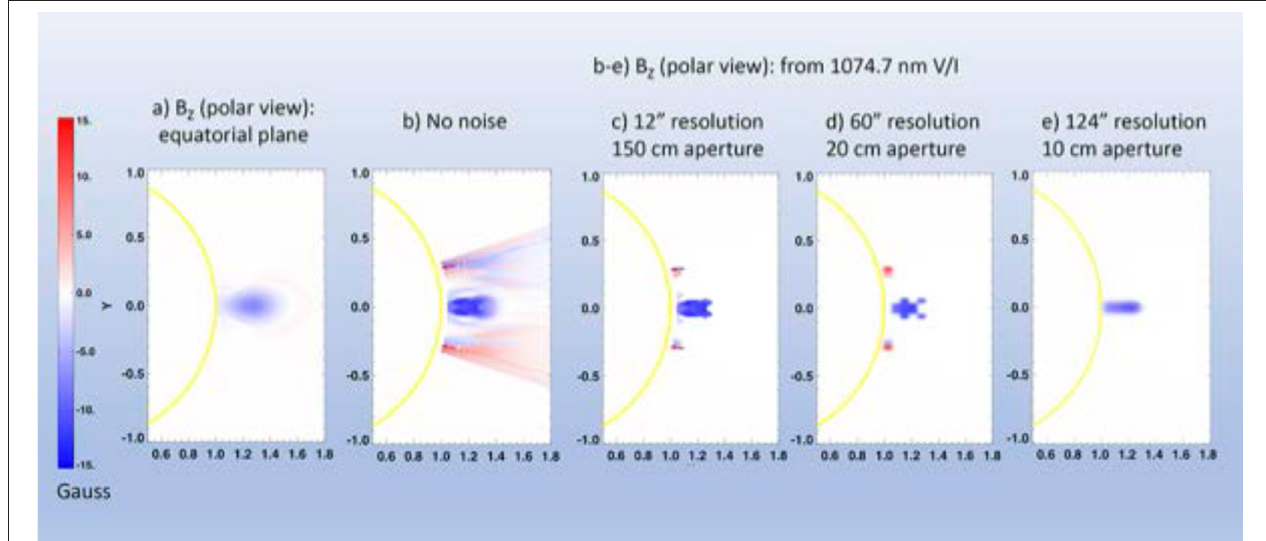
FIGURE 6 | The North-South component of a simulated, erupting CME (Fan, in press) as viewed from the solar North pole. (A) Simulation ground truth B z in equatorial plane. (B) B z inverted from ratio of forward-modeled ( Gibson et al., 2016) Stokes circular polarization V and intensity I. (C) B z values with signal-to-noise ratio > 3, based on a 1.5 m telescope, 12 ′′ spatial resolution, and 5 min integration. This is essentially the same as Fan (in press) Figure 12c, except without the background scatter included in that paper appropriate to ground-based telescopes. (D) Same except for 20 cm telescope and 60 ′′ resolution. (E) Same except for 10 cm telescope and 124 ′′ resolution. Note that the sign and strength of the pre-eruptive core field is captured for